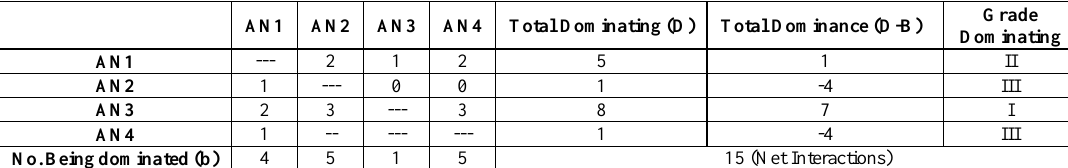
Table 28. Dominance matrix ranking of actions for